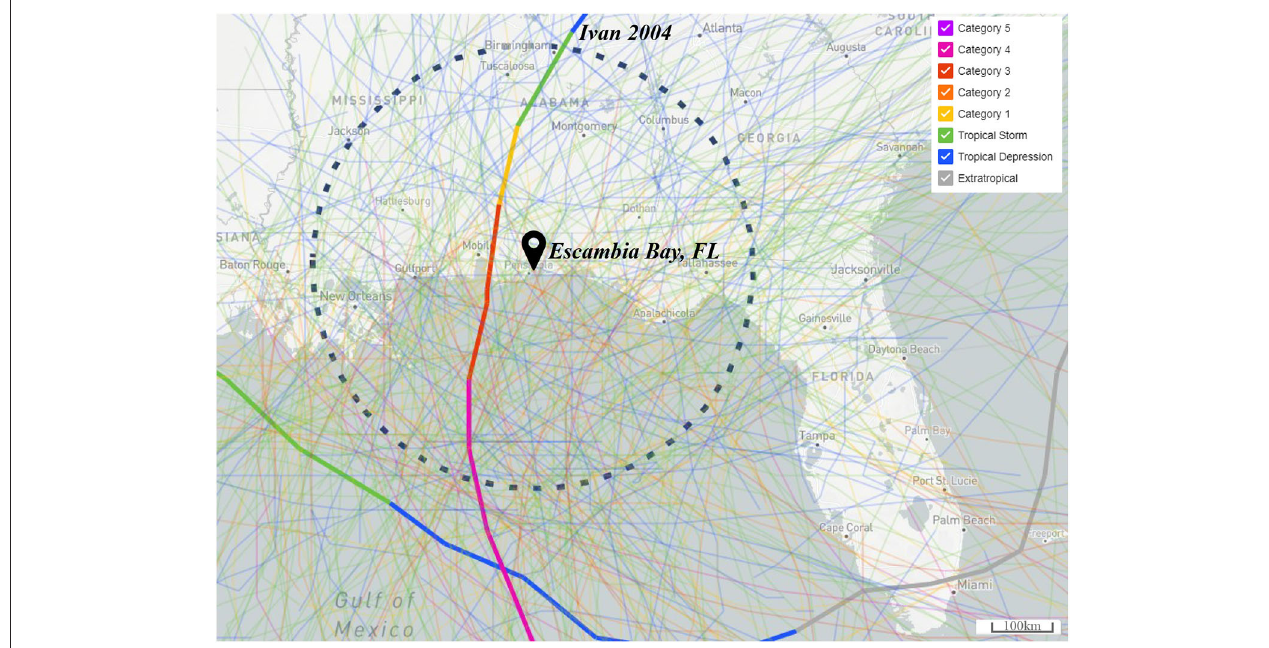
FIGURE 1 | The study area of the bridge in Escambia Bay, Florida, and tracks of historical tropical cyclones, including Hurricane Ivan (adapted from NOAA 2020).